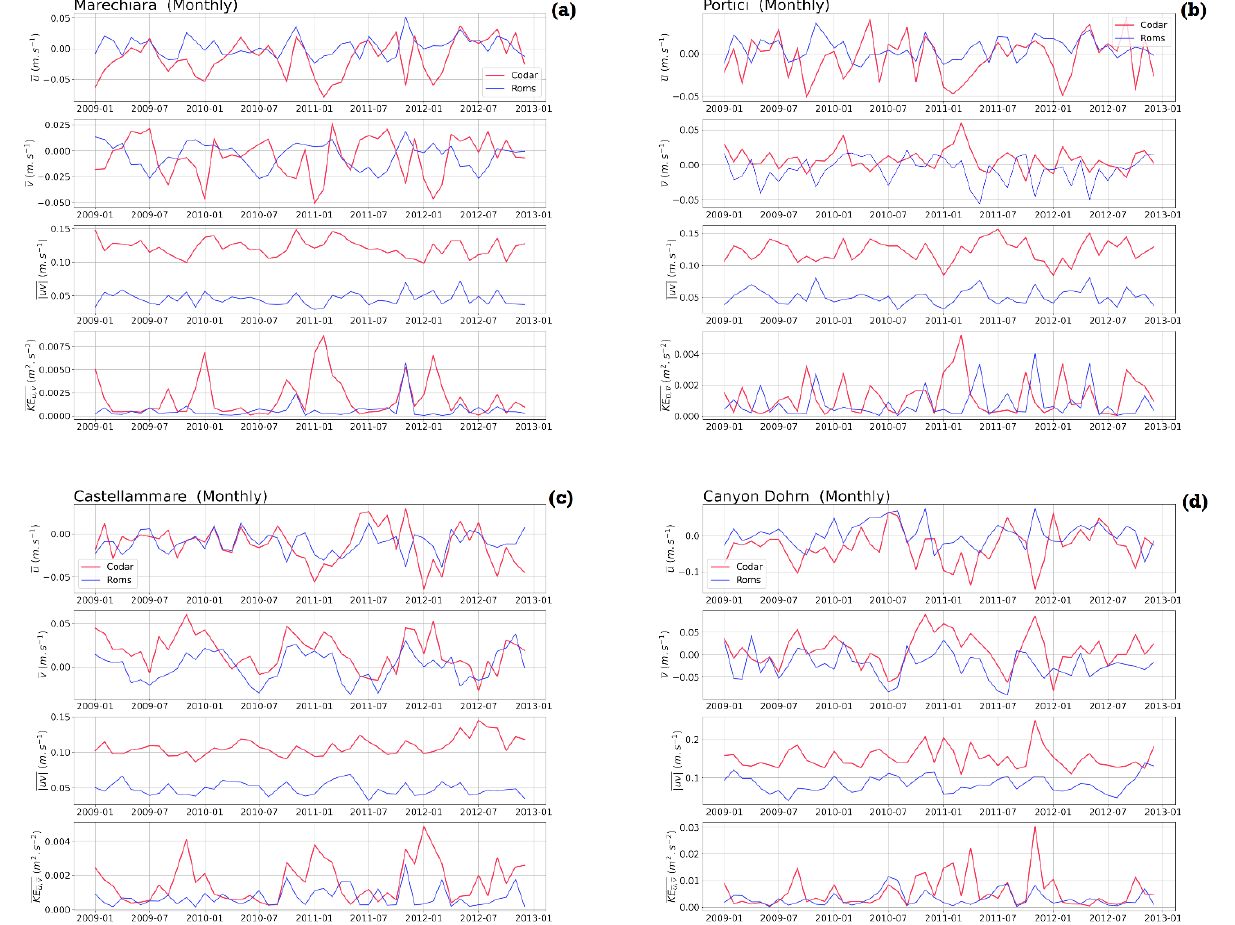
Figure 9. Time series of the monthly averaged velocities (components u , v , and module) and their associated kinetic energy at the four specific areas: ( a ) Marechiara, ( b ) Portici, ( c ) Castellammare and ( d ) Canyon Dohrn. Red: HFR observations; blue: GNAM model.